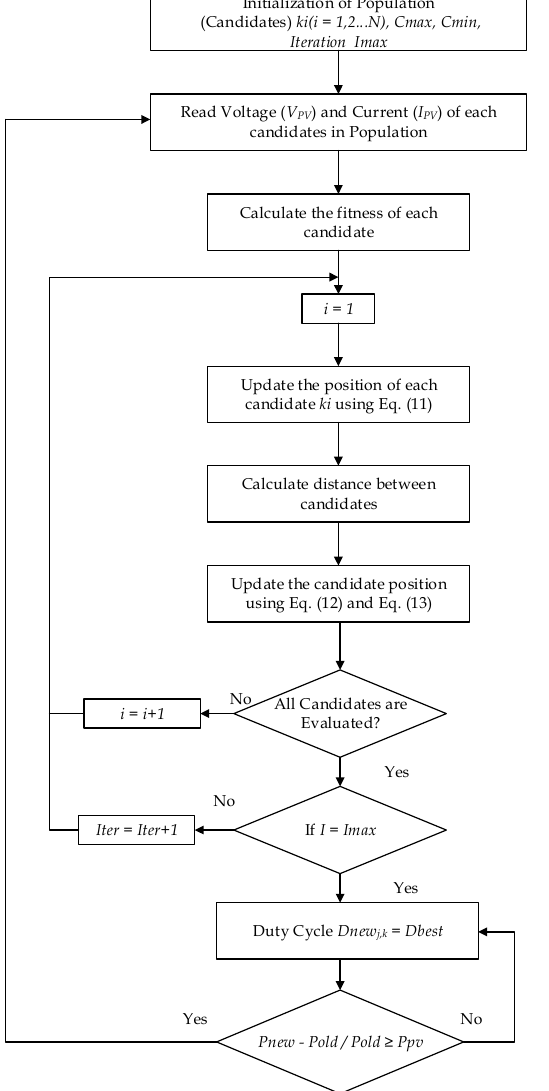
Figure 8. Operational flow chart of the SGO–MPPT